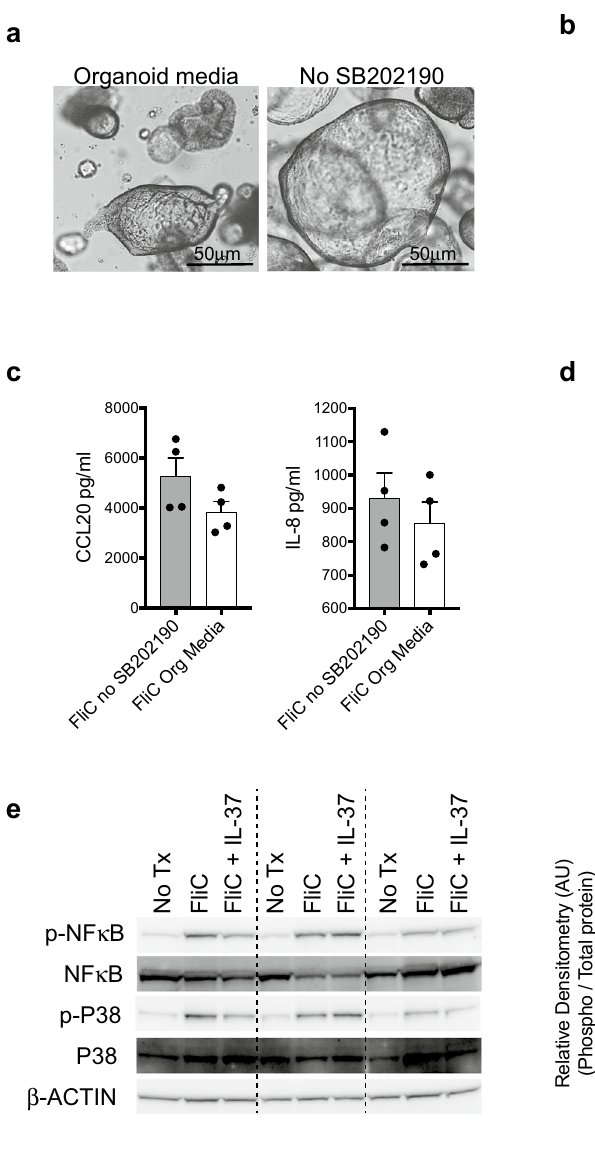
effects were seen at the protein level, we analyzed chemokine/cytokine secretion by ELISA. The same trends were observed at the protein level, with Cxcl1 and Ccl20 showing the greatest reductions in levels when IL-37 was added to stimulated Sigirr +/+ colonoids and this suppression was not observed with Sigirr −/− colonoids (Fig. 5b).